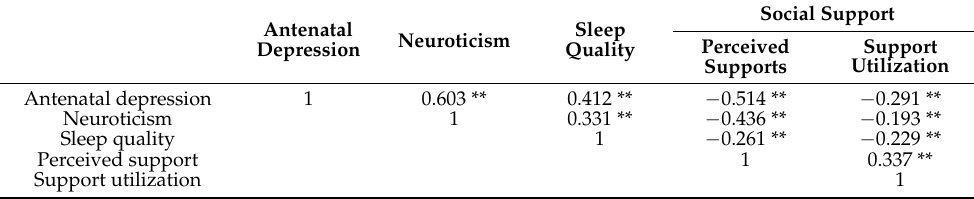
Antenatal Depression Neuroticism